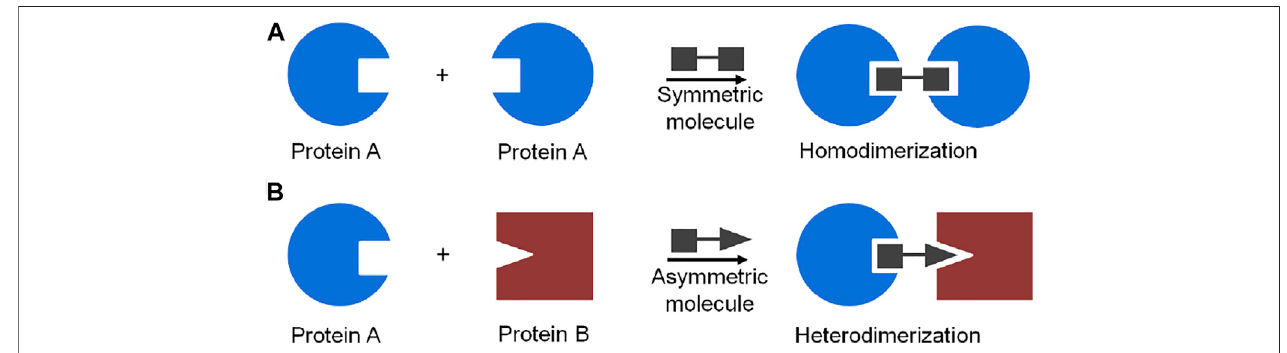
FIGURE 3 | Schematic representation of molecule glue induced dimerization of protein: (A) protein homodimerization induced by a symmetric bifunctional molecule, (B) protein heterodimerization induced by an asymmetric bifunctional molecule.